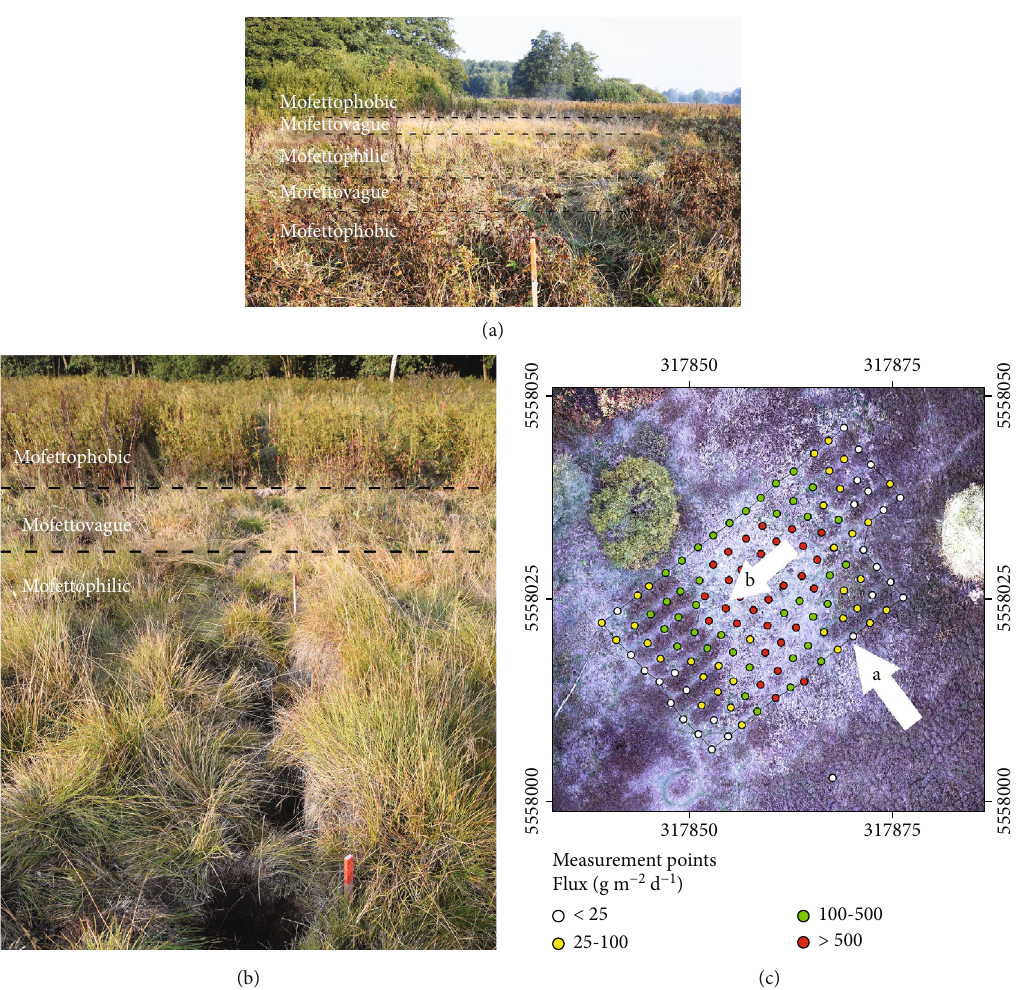
Figure 8: Mofette vegetation. (a) View of the MZ from the southern edge to the NW. (b) View of the MZ from the center to the SW. (c) Soil CO gas fl ux and location and direction of (a) and 2